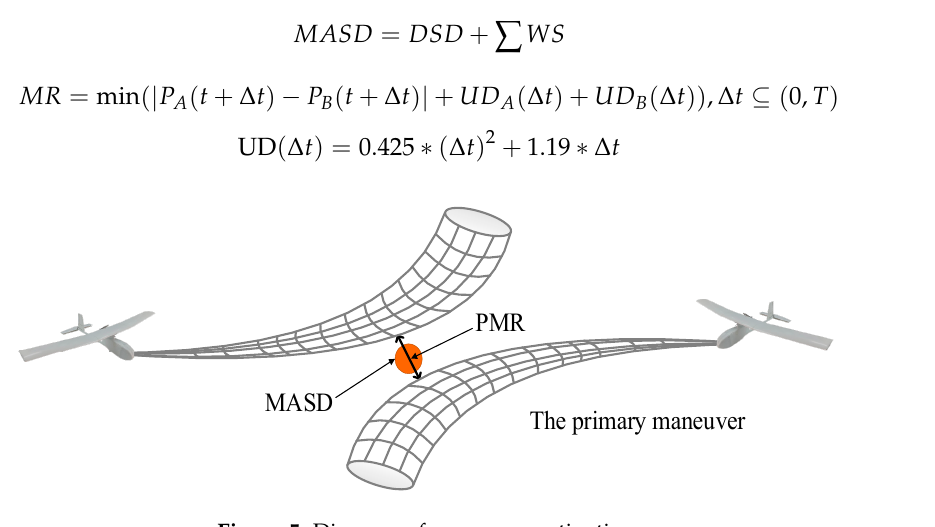
Figure 5. Diagram of maneuver activation.